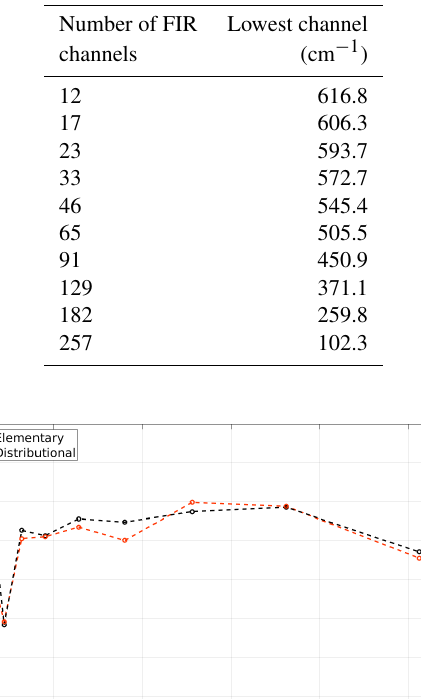
Table 5. The lowest wave number as a function of the number of FIR channels. The sampling rate is constant and set equal to